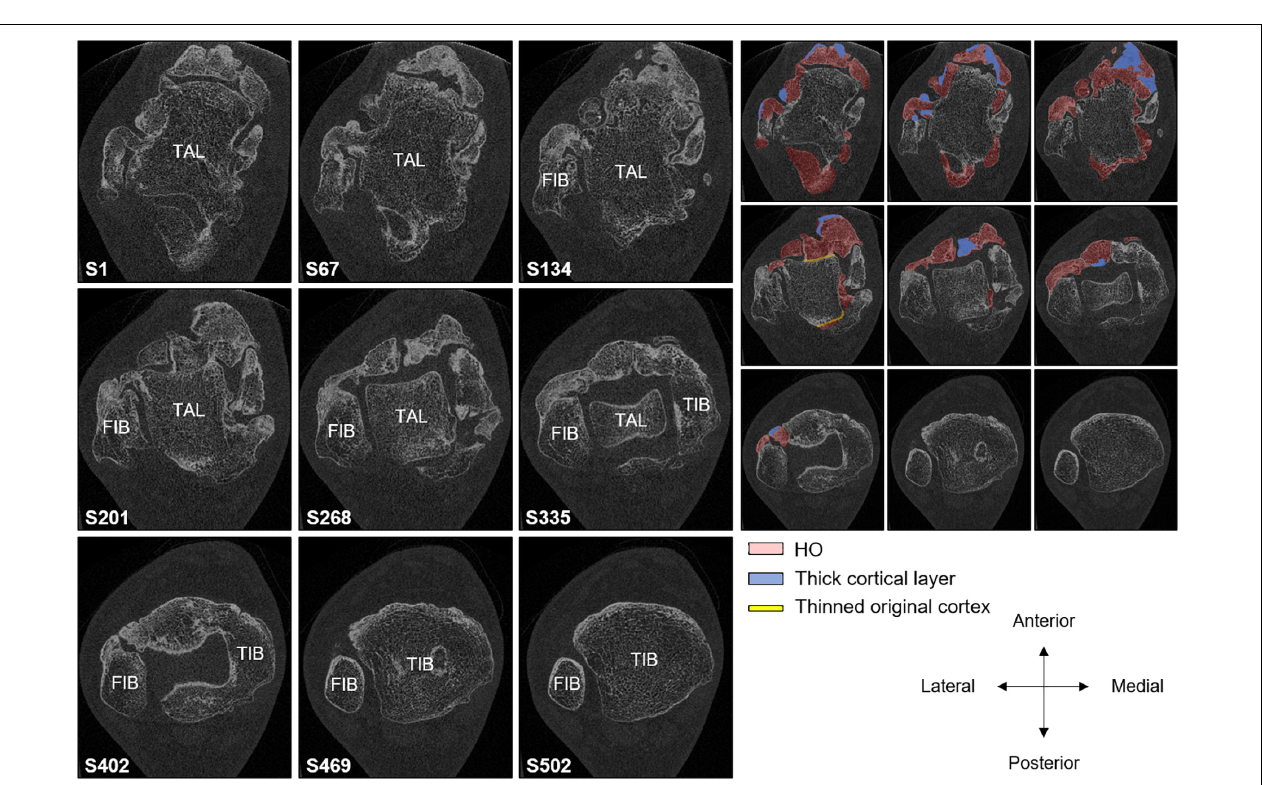
FIGURE 4 | Nine two-dimensional slices of the HR-pQCT scan of a 30.6-mm region of the right ankle of patient 2, a 23-year-old male fibrodysplasia ossificans progressiva (FOP) patient, from distal (S1) to proximal (S502). S1 shows the talus with heterotopic ossification (HO) attached. The original cortical layer of the talus seems disrupted at several sites where HO has fused. (S67–S502) HO has also fused to the fibula. However, a thin cortical layer seems to be present throughout the series. (S201–S502) HO has fused to the tibia; as with the talus, the cortical layer is disrupted at several sites of the fusion. TIB, TAL, and FIB represent tibia, talus, and fibula, respectively. On the right, HO, increased cortical bone, and the thinned cortex are visualized in blue, red, and yellow, respectively. It should be noted that, due to fusion, the exact border between HO and skeletal bone could not be